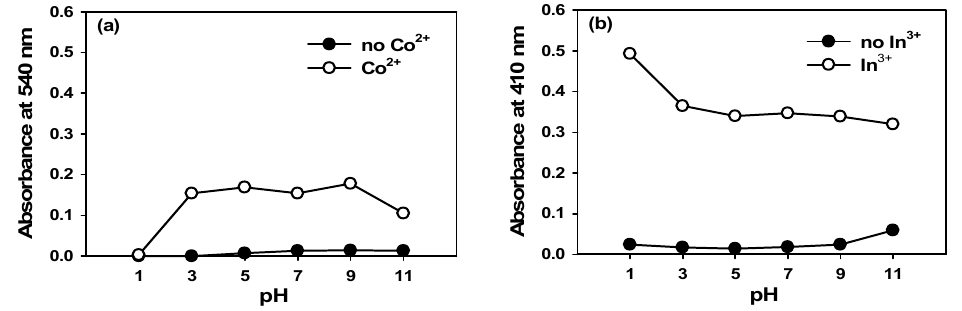
Figure 12. ( a ) Absorbance at 540 nm for MCa-IQ –Co 2+ complex and ( b ) absorbance at 410 nm for MCb-IQ –In 3+ complex at different pH (1–11).